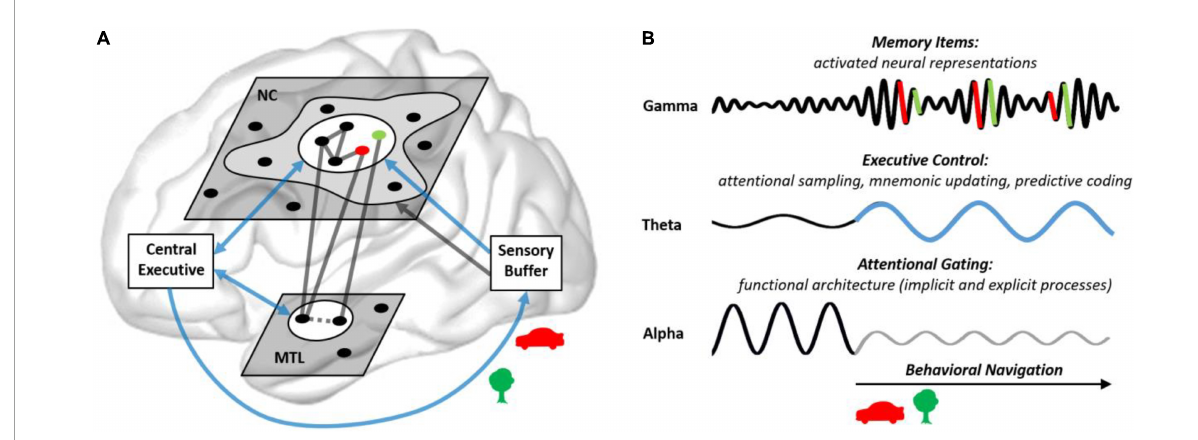
FIGURE5 How brain rhythms may implement the embedded nature of human attention and memory. (A) The central executive (PFC in coalition with attentional and mnemonic control networks, see Figure 1B ) sets the focus of attention on a subset of memory items (indicated by the white circles; see Figure 1A ) in the NC (semantic information) and the MTL (contextual information). For example, on novel items which are attended visually and integrated into associative networks, indexed by the green and red dots (e.g., representing a red car and a green tree). In MTL networks, novel items are integrated (dotted line) into a spatio-temporal map of the outer world. (B) Activated memory items, in distributed cell assemblies, synchronize their firing in gamma bursts ( > 30 Hz). The central executive (blue arrows) selects and integrates memory items and utilizes them for predictions at a theta pace (3–8 Hz). Alpha oscillations (8–14 Hz) gate information processing in semantic networks by inhibiting task irrelevant networks. This shapes a functional architecture underlying explicit and implicit mnemonic processes (including automated processes, not requiring the central executive; gray cloud in A ). An integral aspect of the embedded process model is that explicit as well as implicit mnemonic processes ultimately serve behavioral navigation (including visual